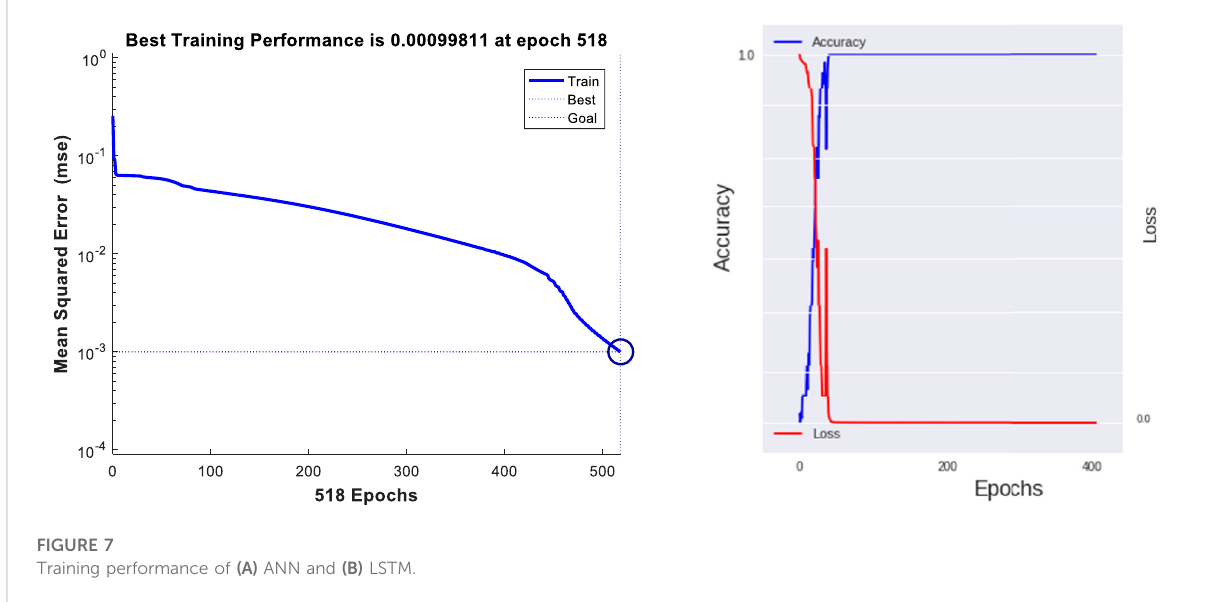
FIGURE 7 Training performance of (A) ANN and (B) LSTM.